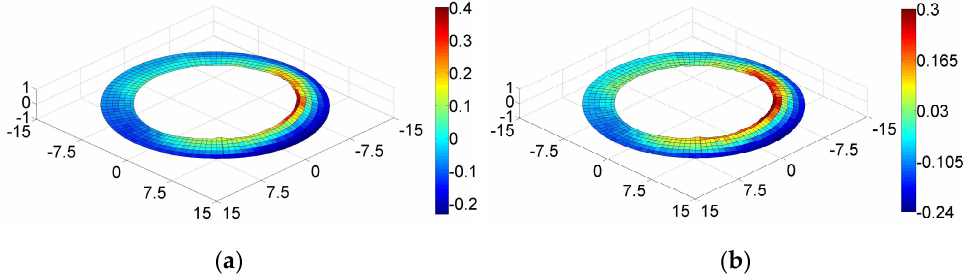
Figure 10. Three-dimensional view of the GCr15 seamless steel tube section. ( a ) Cross-sectional flatness value for test I; ( b ) Cross-sectional flatness value for test IV.